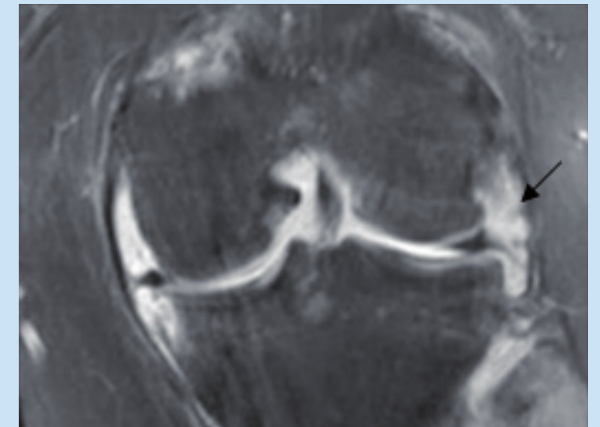
Fig. 1. Proton density fat-saturated MRI. Coronal image demonstrating marginal bone and cartilage erosions, synovial proliferation (arrow) and joint